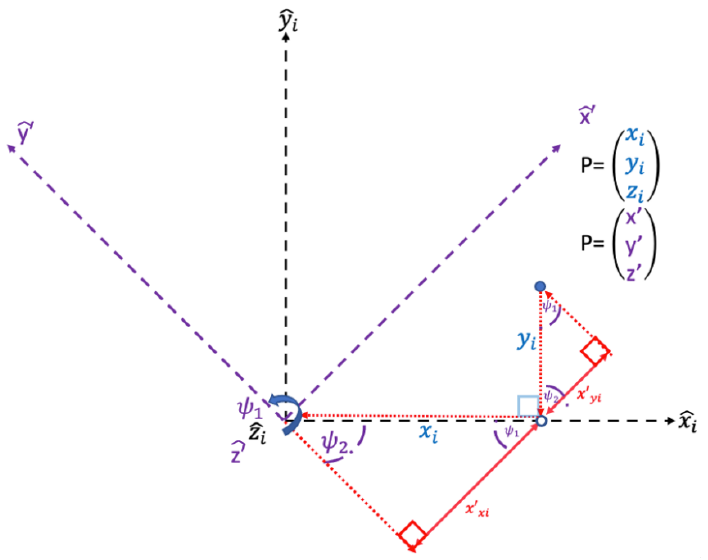
Figure 11. 3-rotation about the 𝑧 𝑖 ̂ and 𝑧′̂ axes highlighting the pertinent similar right triangles.